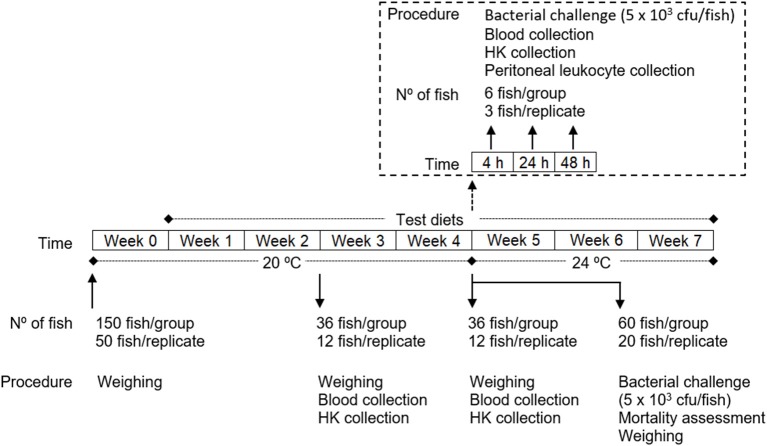
Experimental design.